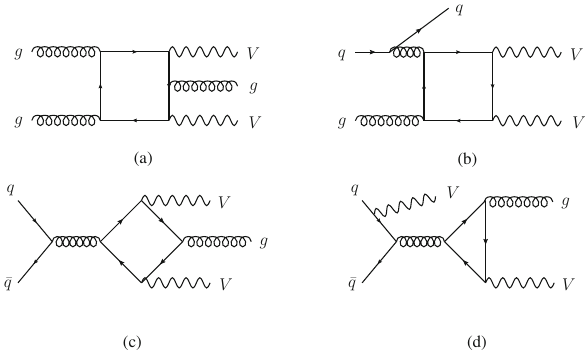
Fig. 1 Real corrections to gluon-induced V V production, with differ- ent partonic